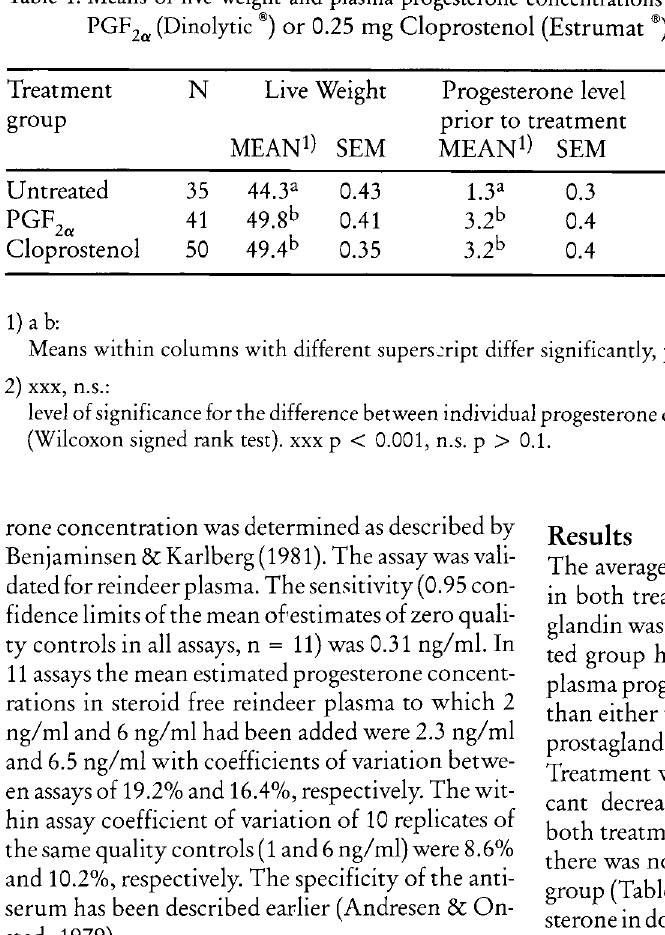
Table 1. Means of live weight and plasma progesterone concentrations prior to and after treatment with 12.5 mg PGF (Dinolytic ®) or 0.25 mg Cloprostenol (Estrumat ®) 2a